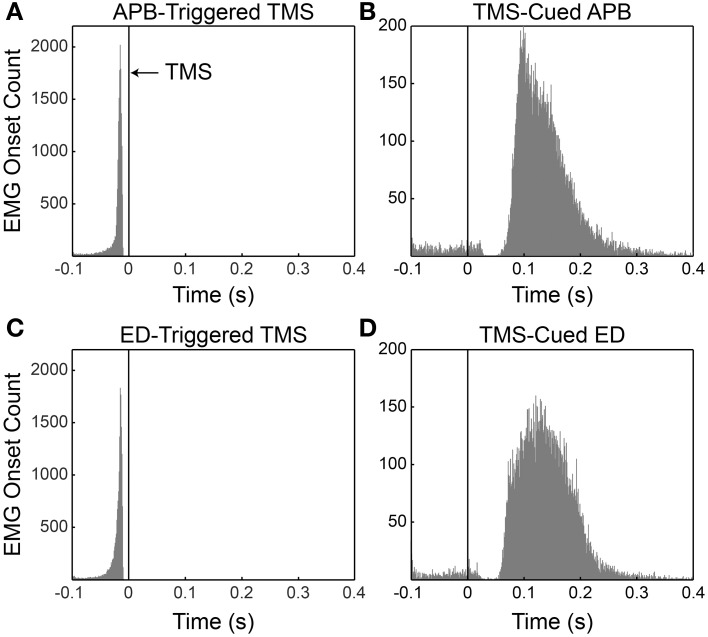
Histograms of volitional EMG onset with respect to the timing of the TMS pulse for all subjects. (A) APB-triggered TMS. (B) TMS-cued APB. (C) ED-triggered TMS. (D) TMS-cued ED. Black vertical lines at t = 0 denote occurrence of the TMS pulse. Note in panels B and D that instances in which EMG onset occurred between −100 and ~25 ms represent premature responses by the subject. The lack of premature responses between ~25 and ~50 ms in panels B and D likely reflects mild cortical inhibition (a very short cortical silent period) induced by the preceding TMS pulse.